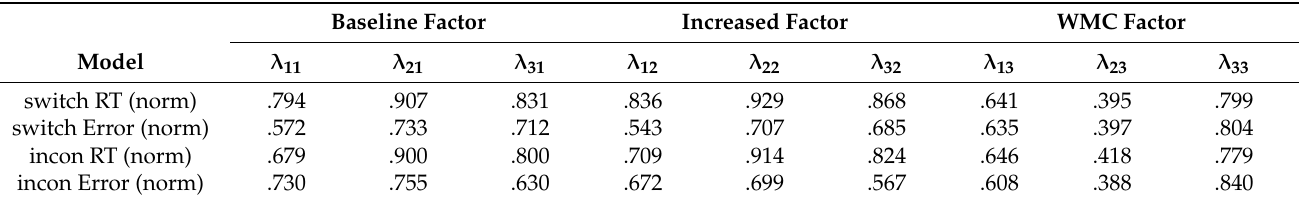
Table A4. Factor loadings of LDS measurement models for observed performance